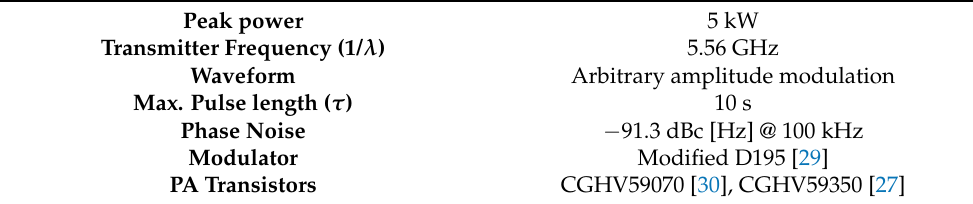
Table 3. Transmitter operating parameters.